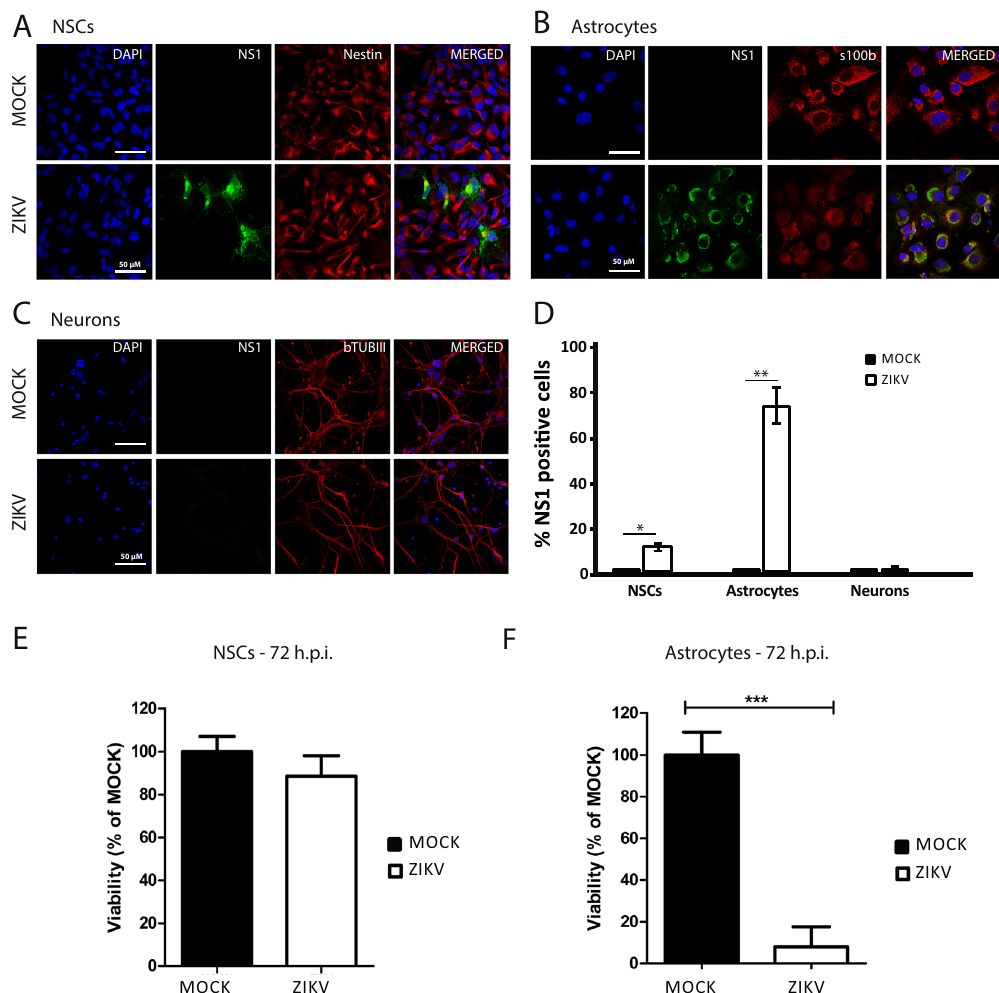
Figure 1. ZIKV infection rate of human brain cells derived from iPSC. ( A – C ). Cells were infected at a multiplicity of infection (MOI) = 1 and analyzed 72 hours post infection (hpi). ( A ). Immunofluorescence images of NSCs stained for ZIKV NS1 protein (green) and Nestin (red). ( B ) Astrocytes stained for ZIKV NS1 protein (green) and S100b (red). ( C ) Neurons stained for ZIKV NS1 protein (green) and beta tubulin III (red). Blue channel is DAPI staining for all cell types. Scale bar: 50 µ m. ( D ). Quantification of the rate of infection according to cell type (Data is shown as average ± SEM. For NSCs, n = 3, derived from iPS lines GM23279A, CF1 and CF2, * p = 0.026; for astrocytes, n = 4, derived from iPS lines GM23279A, CF1, CF2 and C15, ** p = 0.003; for neurons, n = 3, derived from iPS lines GM23279A, CF1 and CF2, non-significant). ( E ) Cell viability assay (MTT) for MOCK and ZIKV-infected NSCs, non-significant, n = 3. ( F ) MTT for MOCK and ZIKV-infected astrocytes, n = 3, *** p < 0.001. Data is shown as average ±